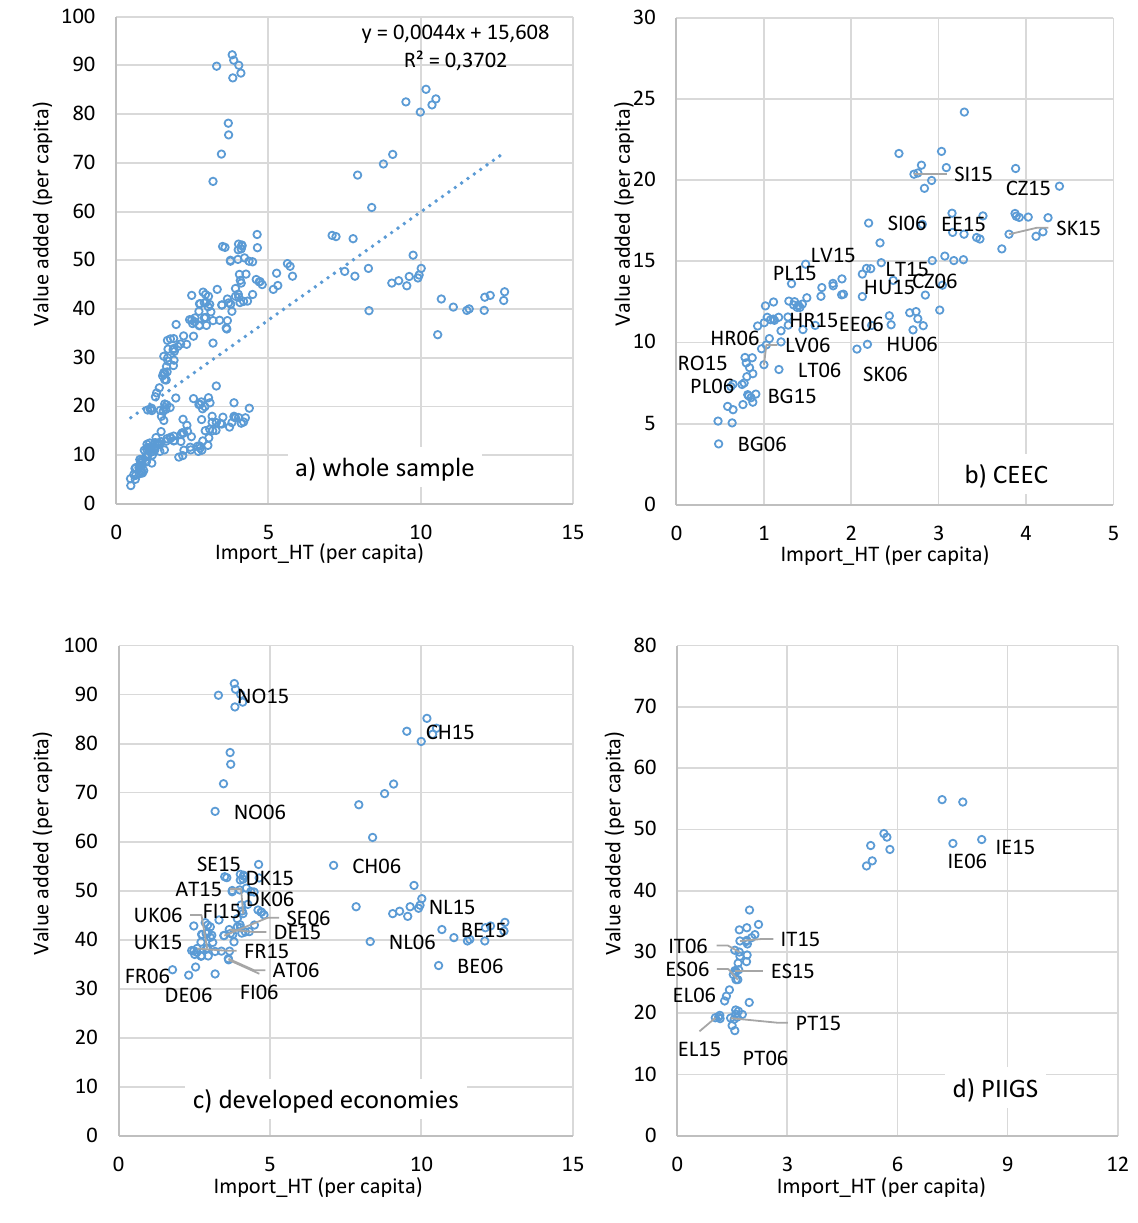
Figure 2. Value added versus high-tech imports (per capita, thousands USD),